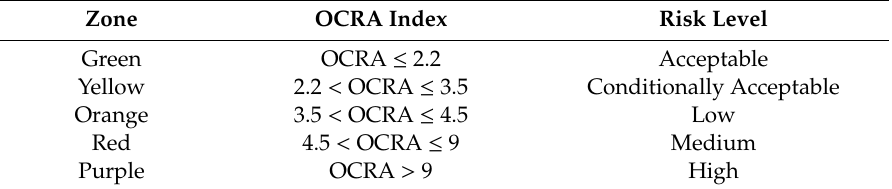
Table 2. Risk levels defined by the Occupational Repetitive Actions Index (OCRA) Index.